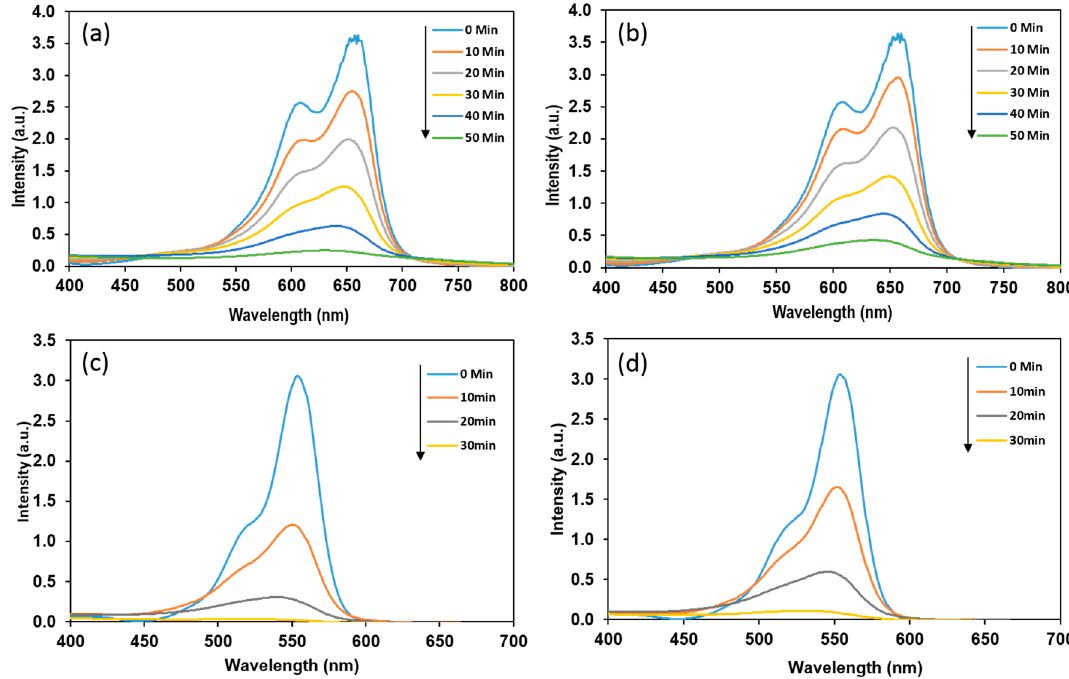
Figure 7. Photocatalytic degradation activity of Bi 2 WO 6 prepared at different flow rates, ( a ) methylene blue using Bi 2 WO 6 nanoplates electrodes (MB-P), ( b ) methylene blue using Bi 2 WO 6 hierarchical buckyball-shaped microsphere electrodes (MB-B), ( c ) rhodamine B using Bi 2 WO 6 hierarchical buckyball-shaped microsphere electrodes (RhB-B), ( d ) rhodamine B using Bi 2 WO 6 nanoplates electrodes